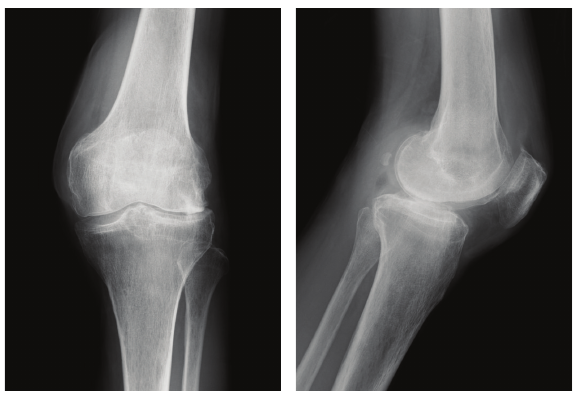
Figure 1: Left knee radiography at 30 months after the onset reveals progressive narrowing of the lateral joint space and osteophyte